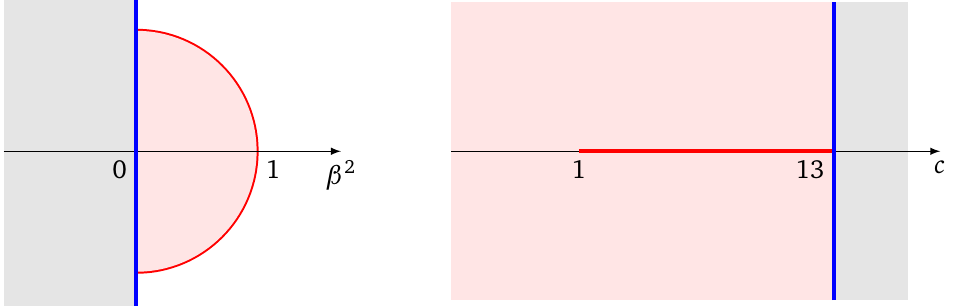
Figure 1: The complex β 2 - and c -planes, with the boundaries of the domains of definition of the even and odd CFTs in blue, and the name-changing lines in